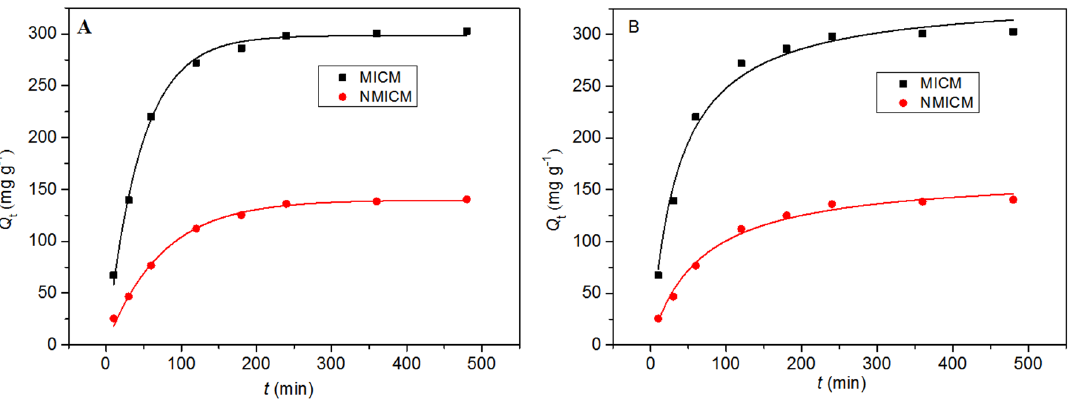
Figure 6. The adsorption kinetic data and fitting curves by the pseudo-first-order model ( A ) and pseudo-second-order model ( B ) at 25 ◦ C for MICM and